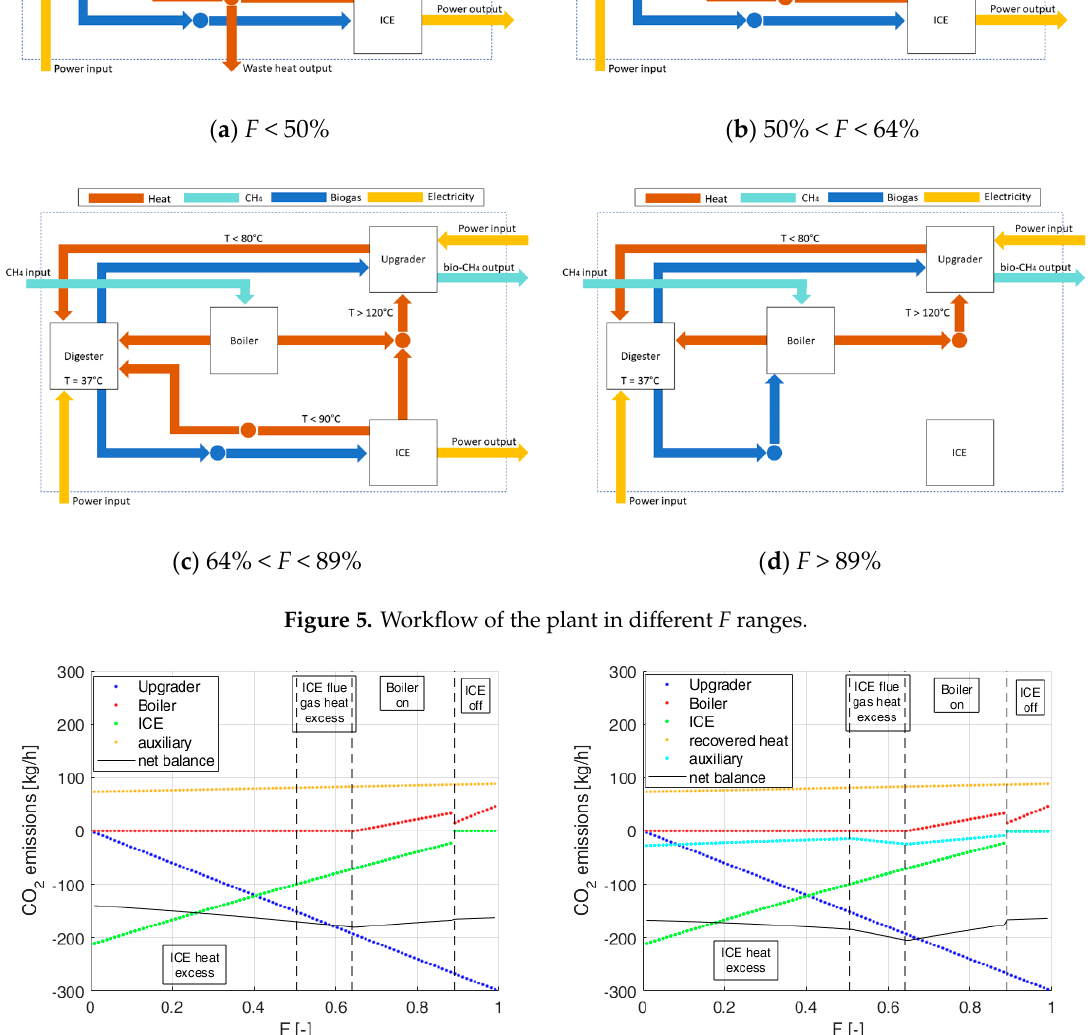
Figure 5. Workflow of the plant in different F ranges.